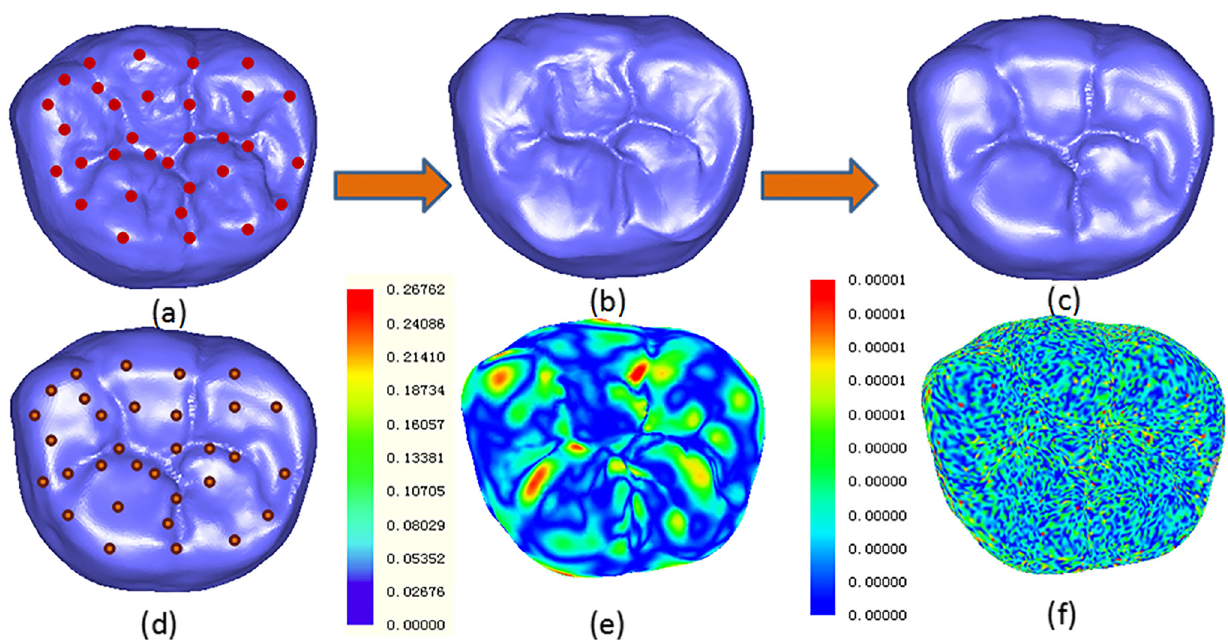
Fig 4. Construction of the homogeneous attrition surface. a. surface without attrition S 0 [16594 points/32894 triangles] and feature points set; b. initial homogeneous surface S h ; c. homogeneous attrition surface after three iterations of contraction and bounding; d. attrition surface S 1 and feature points set; e. error distribution between S h and S 1 ; f. error distribution between S 1 and homogeneous attrition surface after three iterations of contraction and bounding.